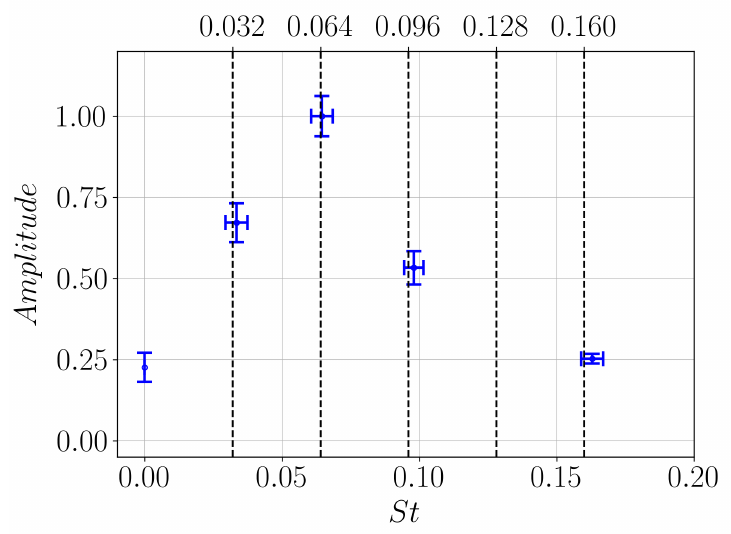
Figure 9. Spectrum of the DMD mean amplitudes and Strouhal numbers ( St ). The vertical and horizontal error bars on the data points are that of the 95% confidence intervals of the amplitude and St , respectively. The vertical broken lines are of St n = 0.032 and its harmonics 2 St n , 3 St n , 4 St n and 5 St n